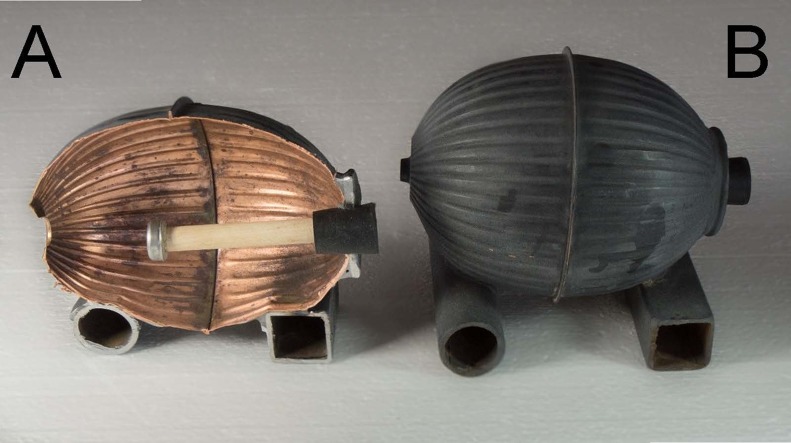
Cross-section of an operative temperature model (A) and an intact model (B) used to characterize the thermal environment in pygmy rabbit (Brachylagus idahoensis) habitat in eastern Idaho, USA.Photo credit: Charles Peterson.